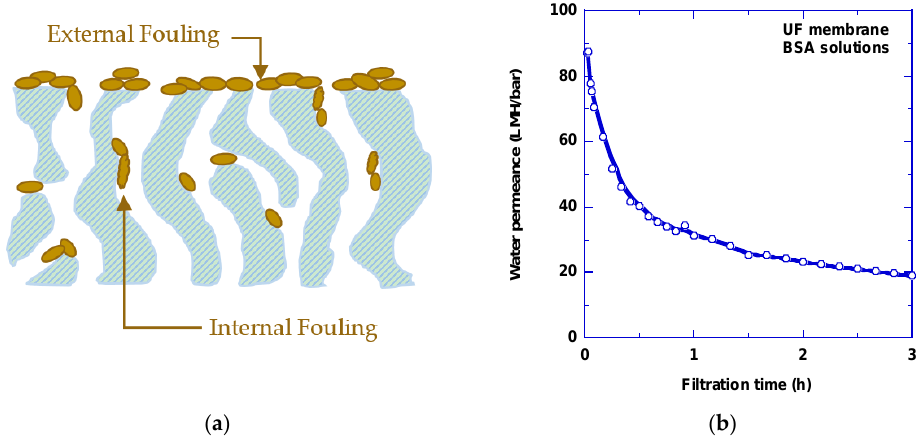
Figure 1. ( a ) Schematic showing external and internal fouling of membranes caused by contaminants from feed water; ( b ) an example of the decrease of water permeance over time caused by bovine serum albumin (BSA) in an ultrafiltration (UF) membrane (polyacrylonitrile (PAN)-50). The BSA concentration and pH of the solution were 0.3 g/L and 7.4, respectively [8].